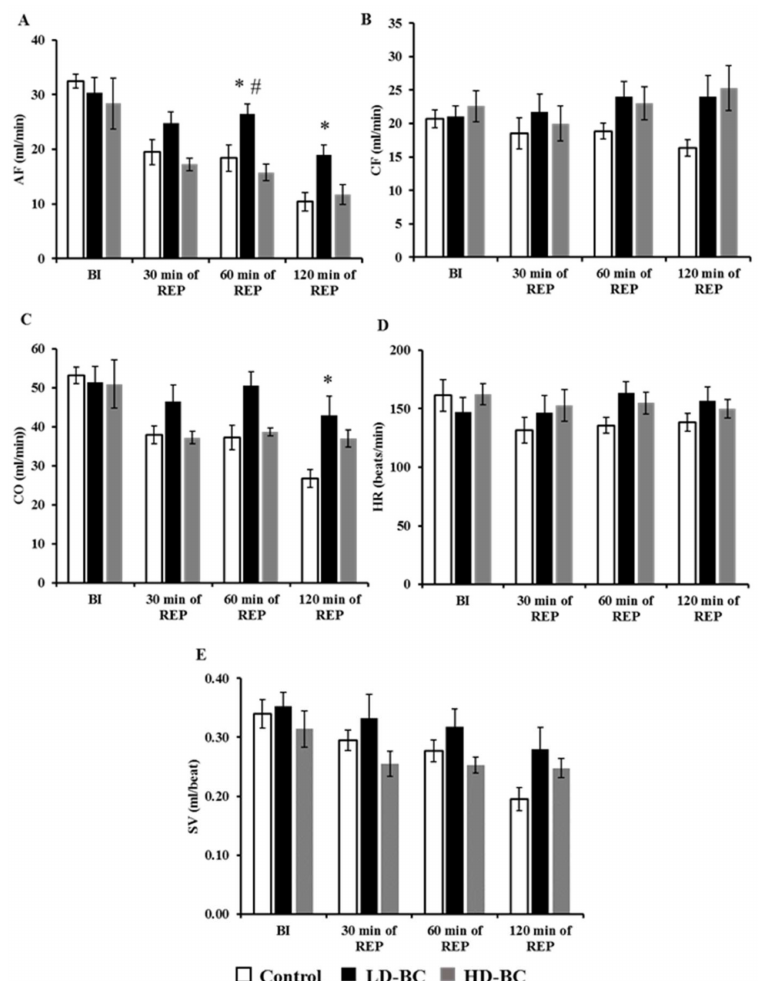
Figure 1. The beta-carotene (BC) effects on cardiac function in isolated working hearts. Hearts were isolated from rats ( n = 8 per group) received hydroxyethyl cellulose-water (1:4) as a vehicle control (open bars); BC 30 mg/kg/day (black bars); or BC 150 mg/kg/day (gray bars) for 4-week time periods. Isolated hearts were subjected to 30 min of global ISA followed by 120 min of REP in an isolated “working-heart” apparatus. Results are shown as the mean ± SEM of AF ( A ); CF ( B ); CO ( C ); HR ( D ), and SV ( E ). * p < 0.05 in comparison with the magnitude of each cardiac function measured in each test group receiving BC, relative to the hearts of vehicle-treated control animals. # p < 0.05 for comparison of the magnitude of cardiac function measured in LD-BC relative to the hearts from HD-BC treated animals. BC: beta-carotene, BI: before ISA, ISA: ischemia, REP: reperfusion, AF: aortic flow, CF: coronary flow, CO: cardiac output, HR: heart rate, SV: stroke